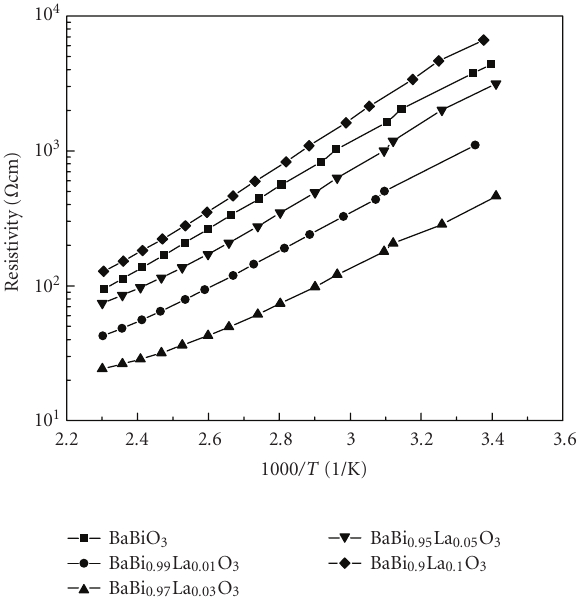
Figure 3: Resistivity-1/ T curves of BaBi 1 − x La x O 3 ceramics sintered at 750 ◦ C for 4